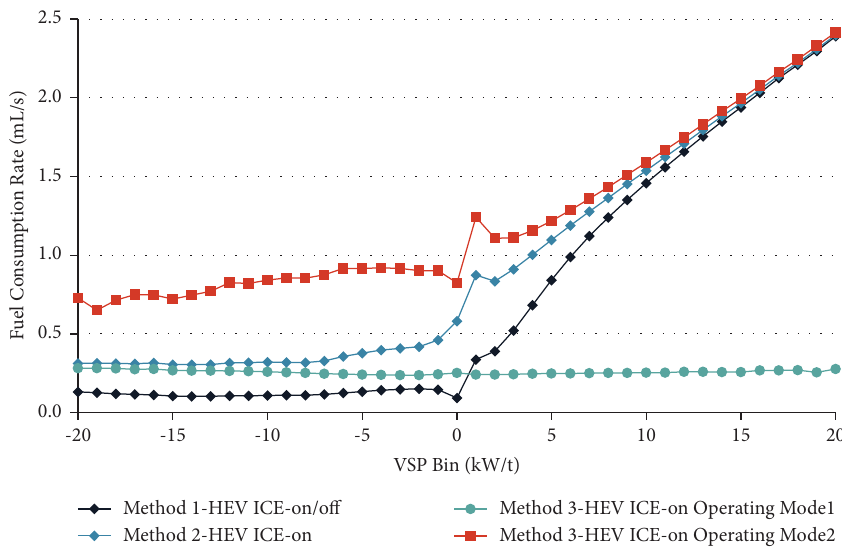
Figure 9: Te FCR in diferent HEV ICE